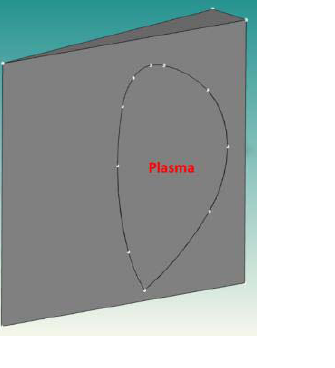
Figure 3. Map of neutron flux and error calculated by SuperMC for void model